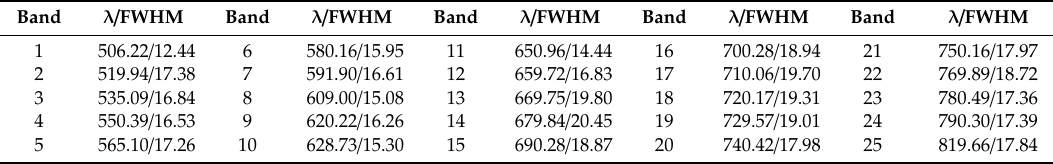
Table 1. Spectral setting of the Rikola camera. λ represents the central wavelength and FWHM is the full width at half maximum. Both values in nanometers